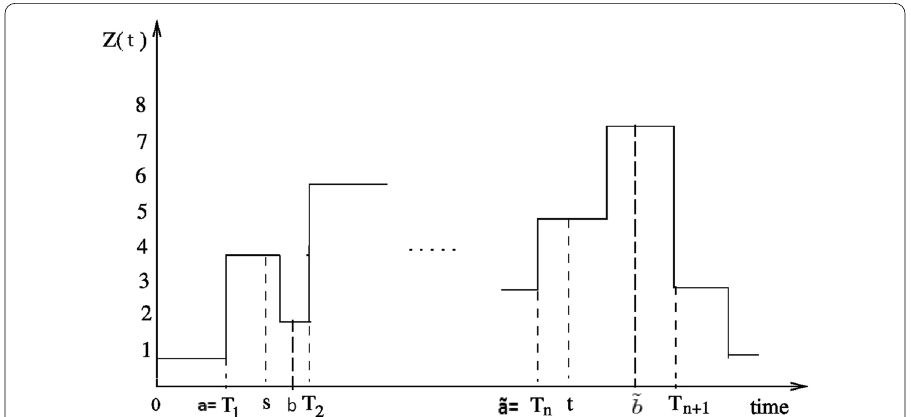
Fig. 1 Sample path of non-homogeneous MRGP with recurrence times. At initial time s , the system is in state i but it entered state i at time T 1 , that is, the backward process is s − T 1 and the forward process is T 2 − s . Similarly, at the final time t , the backward process is t − T n and the forward process is T n + 1 − t . On the contrary, in case of homogeneous MRGP, backward and forward process values are assumed to be equal to